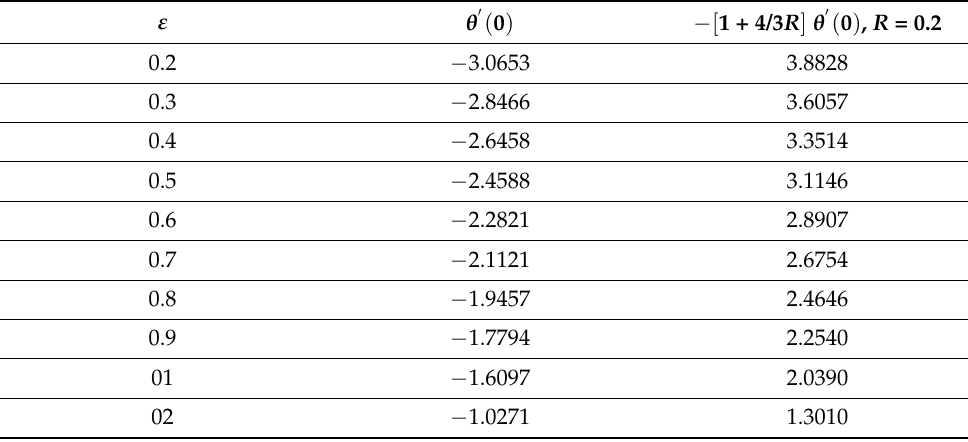
Table 7. Impact of variable thermal conductivity on Nusselt number.